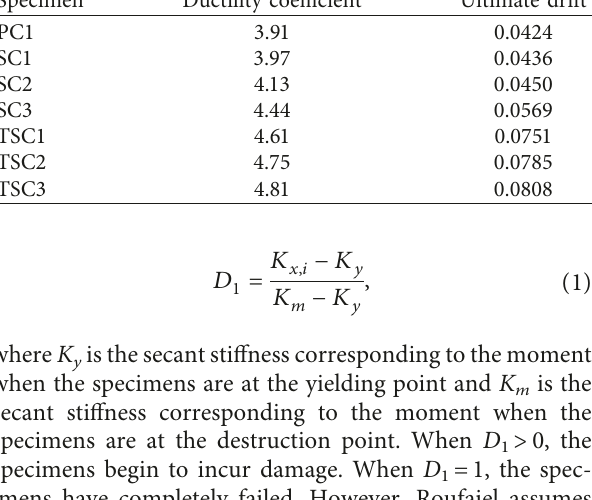
Table 6: Displacement ductility coefficients for the specimens.